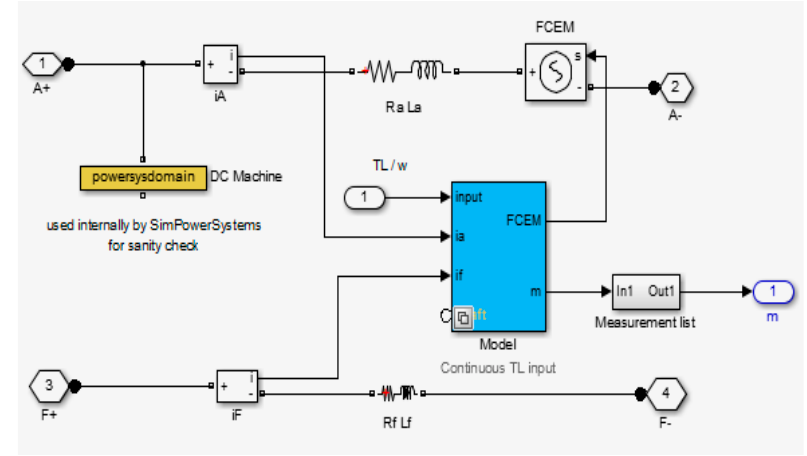
Figure 6. Simulink model of SEDC motors.